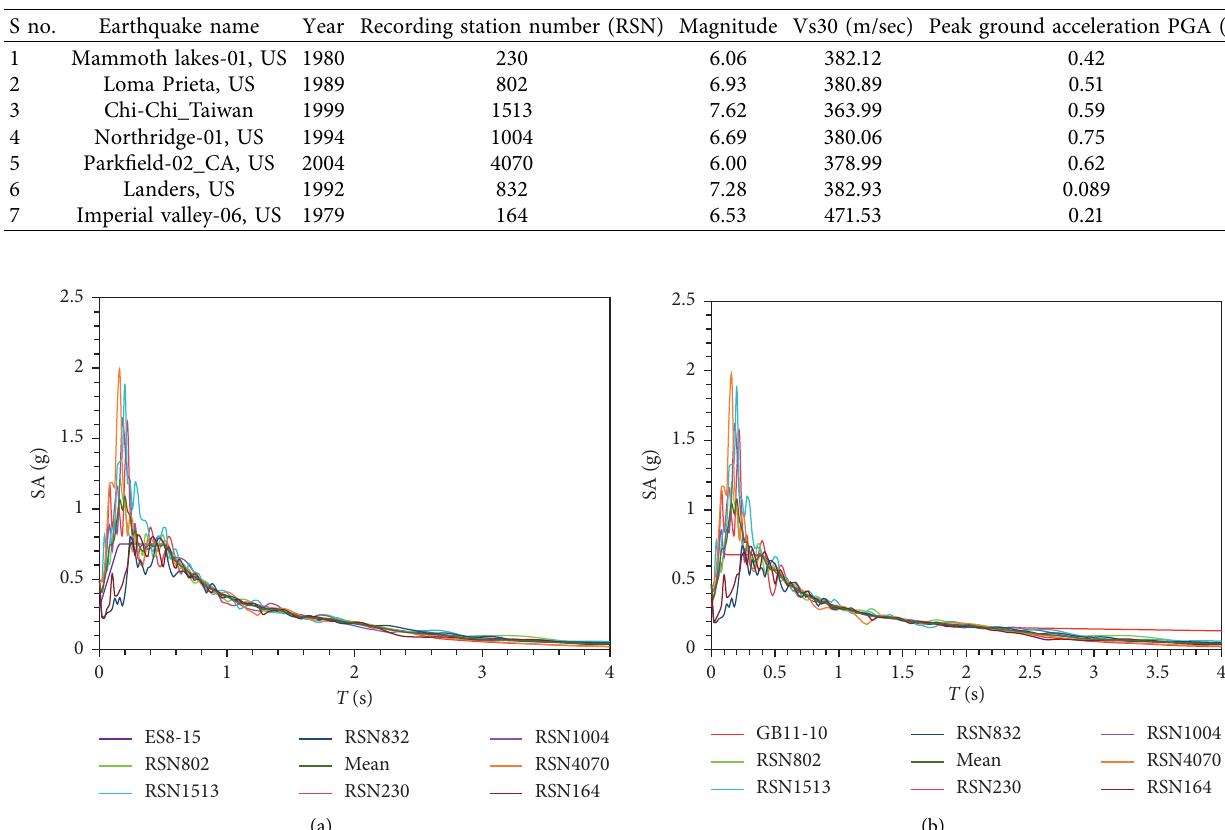
Figure 6: Matched response spectrum for (a) 8A and (b) 8B-Model Buildings (for PGA � 0.3g, soil II, and 0.25g, soil-A).